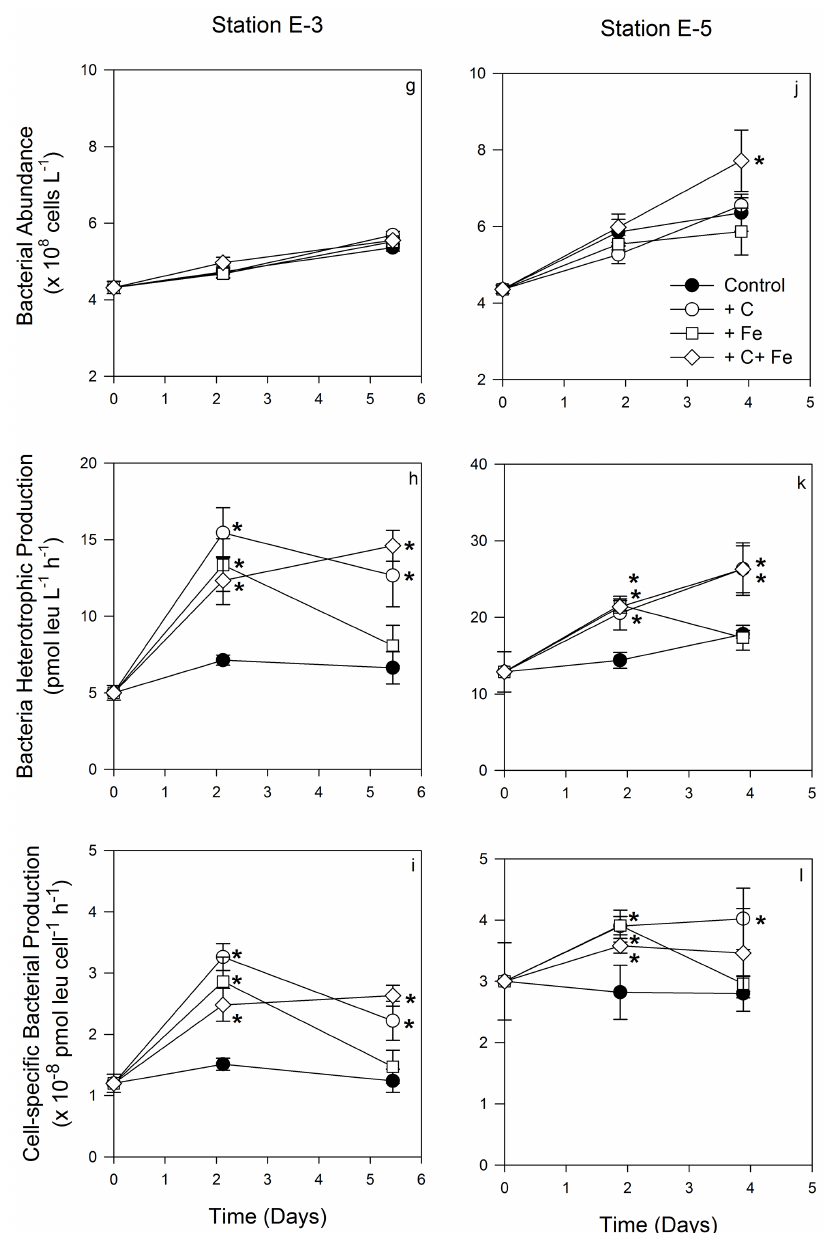
Figure 1. Changes in bacterial abundance (upper panels), bacterial heterotrophic production (middle panels) and cell-specific bacterial production (lower panels) in the control, C-amended, Fe-amended, and both C- and Fe-amended treatments over time. Treatments with an asterisk are significantly different from the control (one-way analysis of variance (ANOVA) and post hoc Tukey; p <0.05).